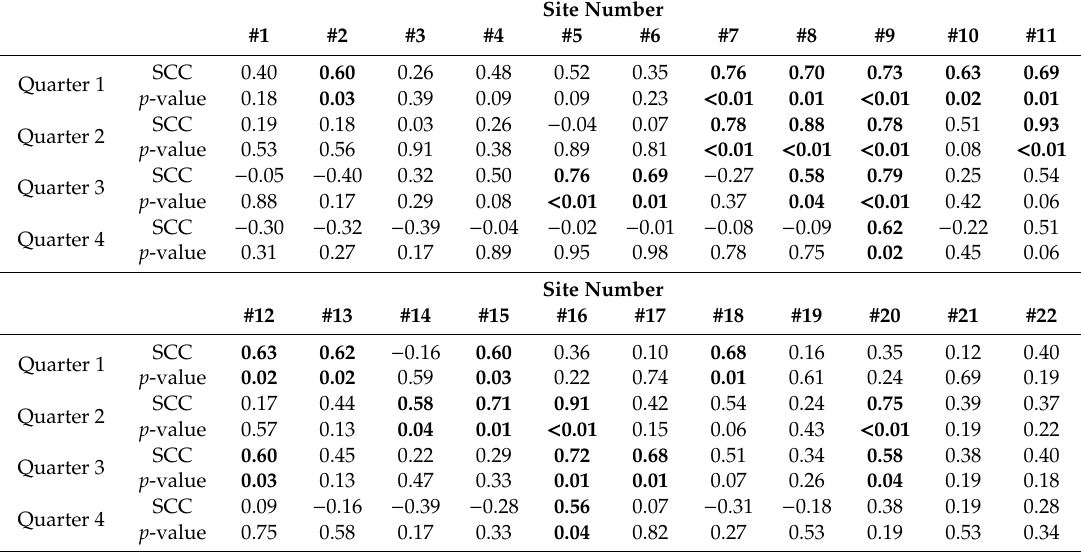
Table 5. Results of Spearman’s correlation test, including quarterly E. coli concentration (CFU per 100 mL) and quarterly SPM concentration (mg / L) at each sampling location (n = 22) during the study period (2 January 2018–1 January 2019) in West Run Watershed, WV, USA. Note: Quarter 1 represents 2 July 2018–25 September 2018; Quarter 4 represents 2 October 2018–1 January 2019. Bold values indicate significant correlations ( p <